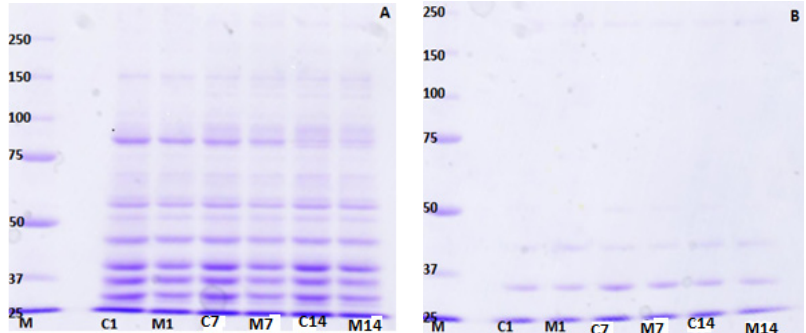
Figure 1. Sodium dodecyl sulfate–polyacrylamide gel electrophoresis profile of sarcoplasmic (A) and myofibrilar proteins (B) of duck breast meat (C, unmarinated; M, marinated at 1, 7, and 14 days,